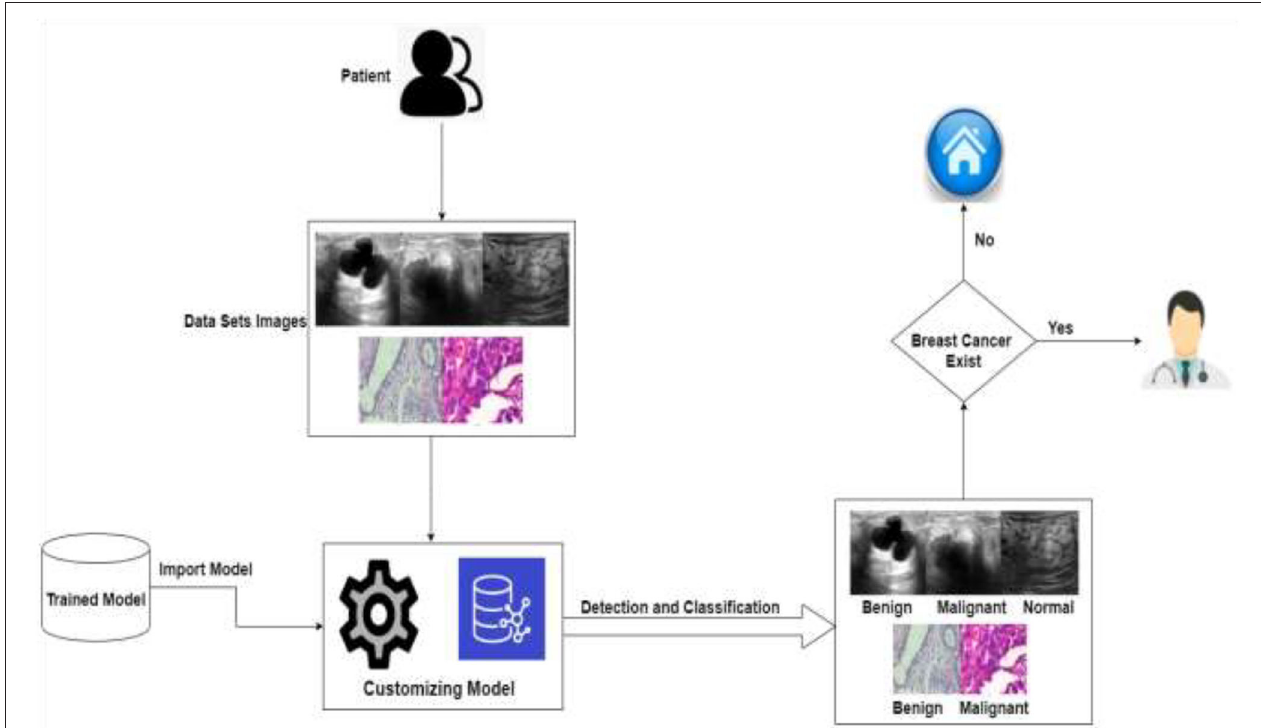
FIGURE 3 | Application level of the proposed system.